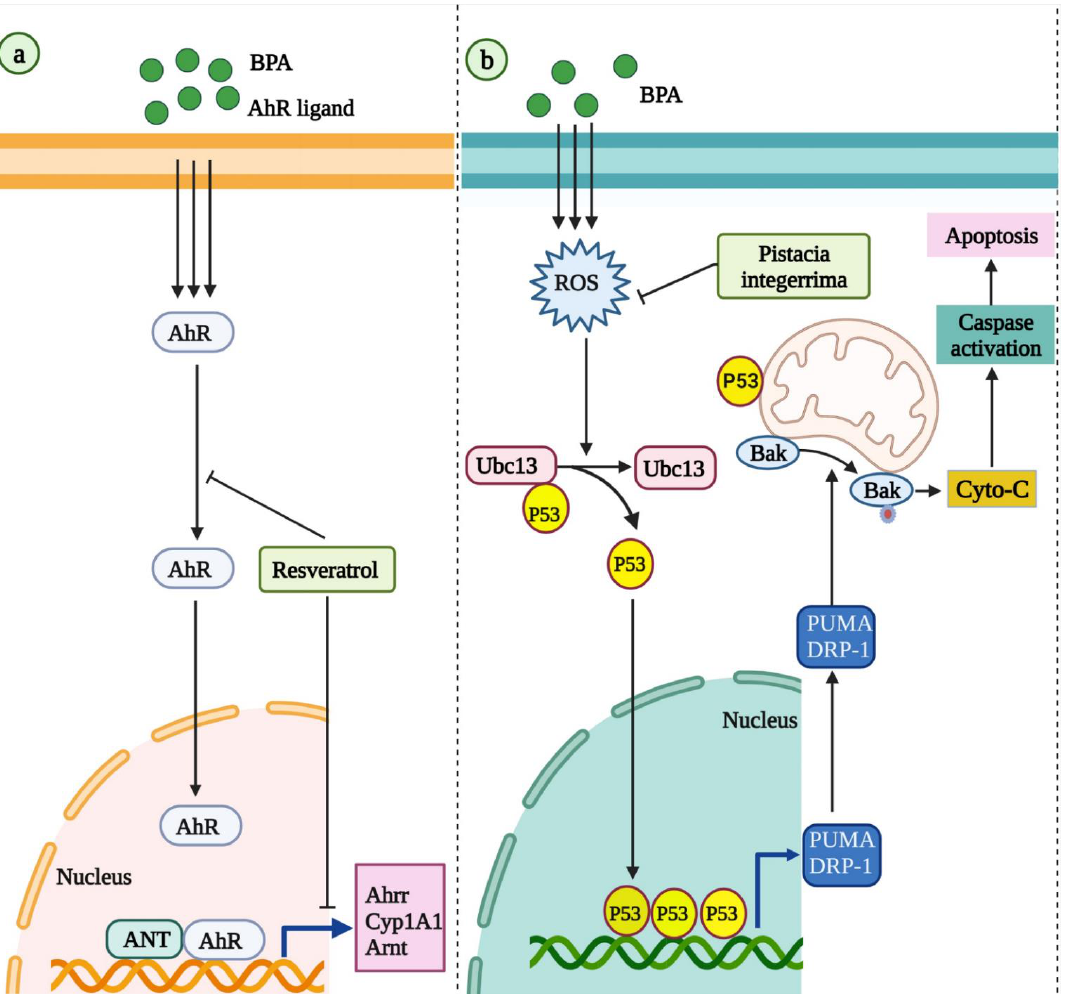
Figure 1. ( a ) The antioxidant effects of resveratrol against BPA and high-fat-diet-induced developmental programming of hypertension through the AhR signaling pathways [160]. ( b ) The molecular mechanisms involved in the anti-apoptotic effects of Pistacia integerrima against BPA exposure-induced toxicity in heart tissue [157]. AhR: aryl hydrocarbon receptor; Cyp1a1: cytochrome P450 Cyp1a1; Cyto C: cytochrome C; PUMA: P53 upregulated modulator of apoptosis; Drp1: dynamin-related protein 1; Ubc13: ubiquitin-conjugating enzyme variant.